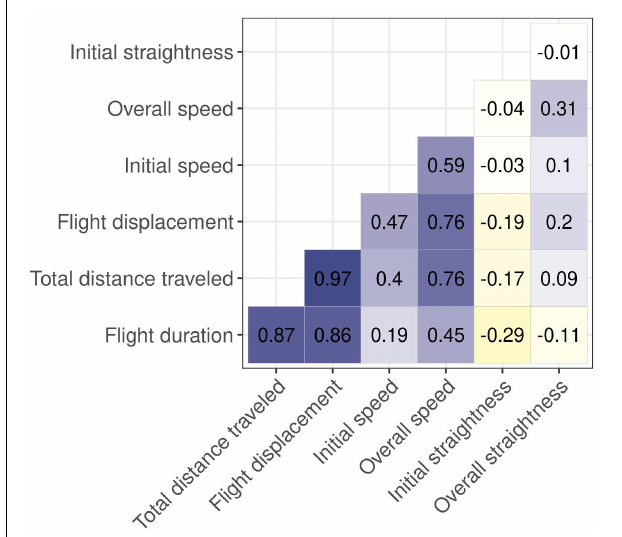
FIGURE 4 | Correlation matrix with correlation coefficients showing relations between the variables, using non-parametric Spearman’s rank-order correlation test based on experimental approach trials by humans on wolves in south-central Scandinavia,